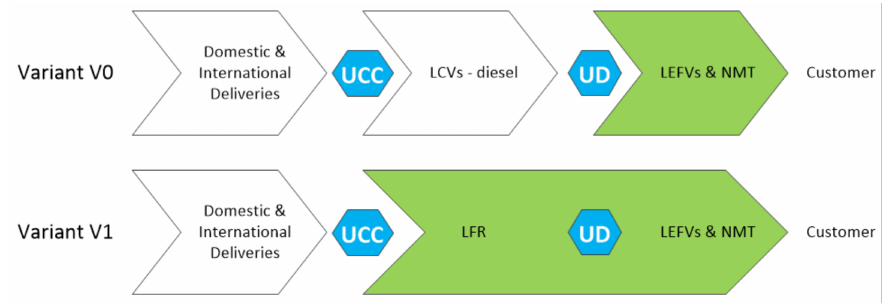
Figure 8. Diagrams of urban delivery systems for variants V0 and